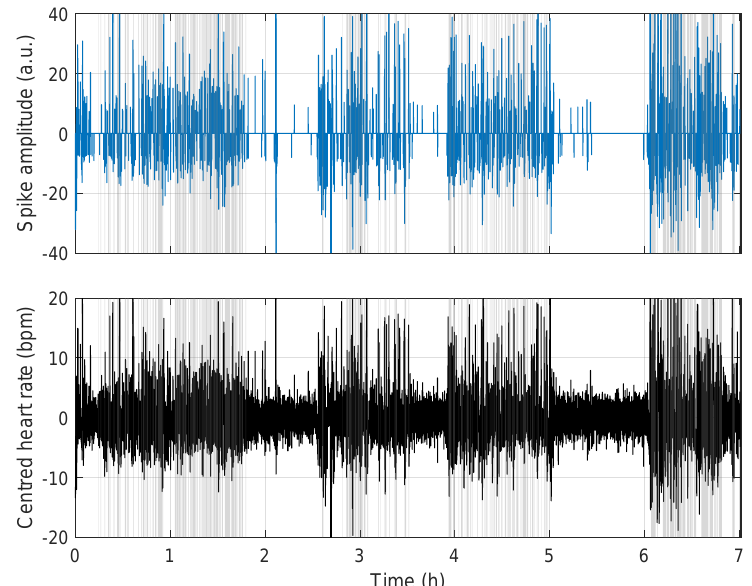
Figure 9. Example where the model works as intended for a whole night. The figure shows the output of the sparse model (upper blue spikes), the high-pass filtered heart rate (lower black curve), and the ground-truth apnoea (vertical grey patches).